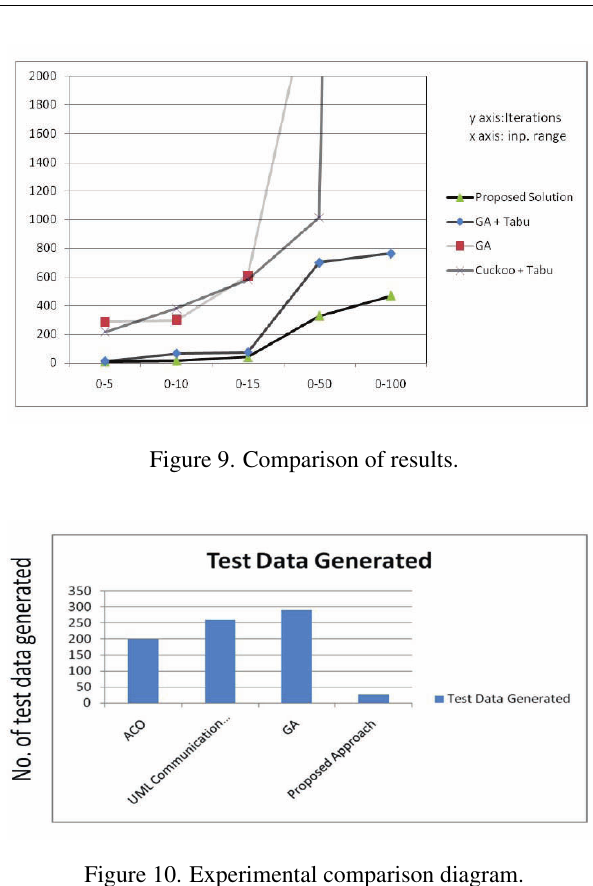
Figure 10. Experimental comparison